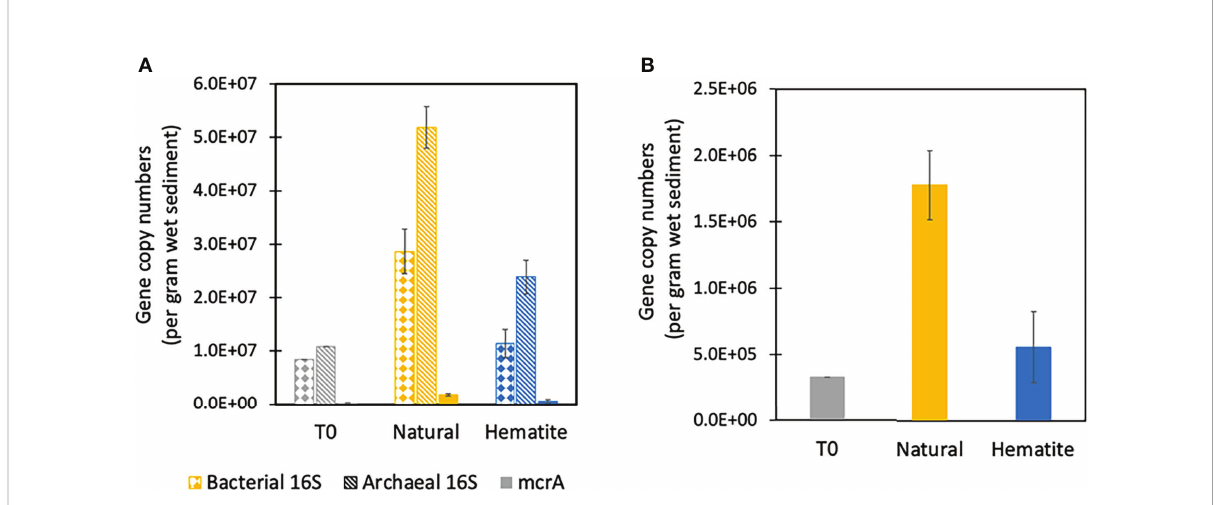
FIGURE 4 Functional gene copy counting per gram wet sediment on T0, natural and added hematite treatments from MS experiment. (A) Bacterial, archaeal and mcrA counts, which are shown in dotted, dashed and solid lines, respectively. (B) Only the mcrA